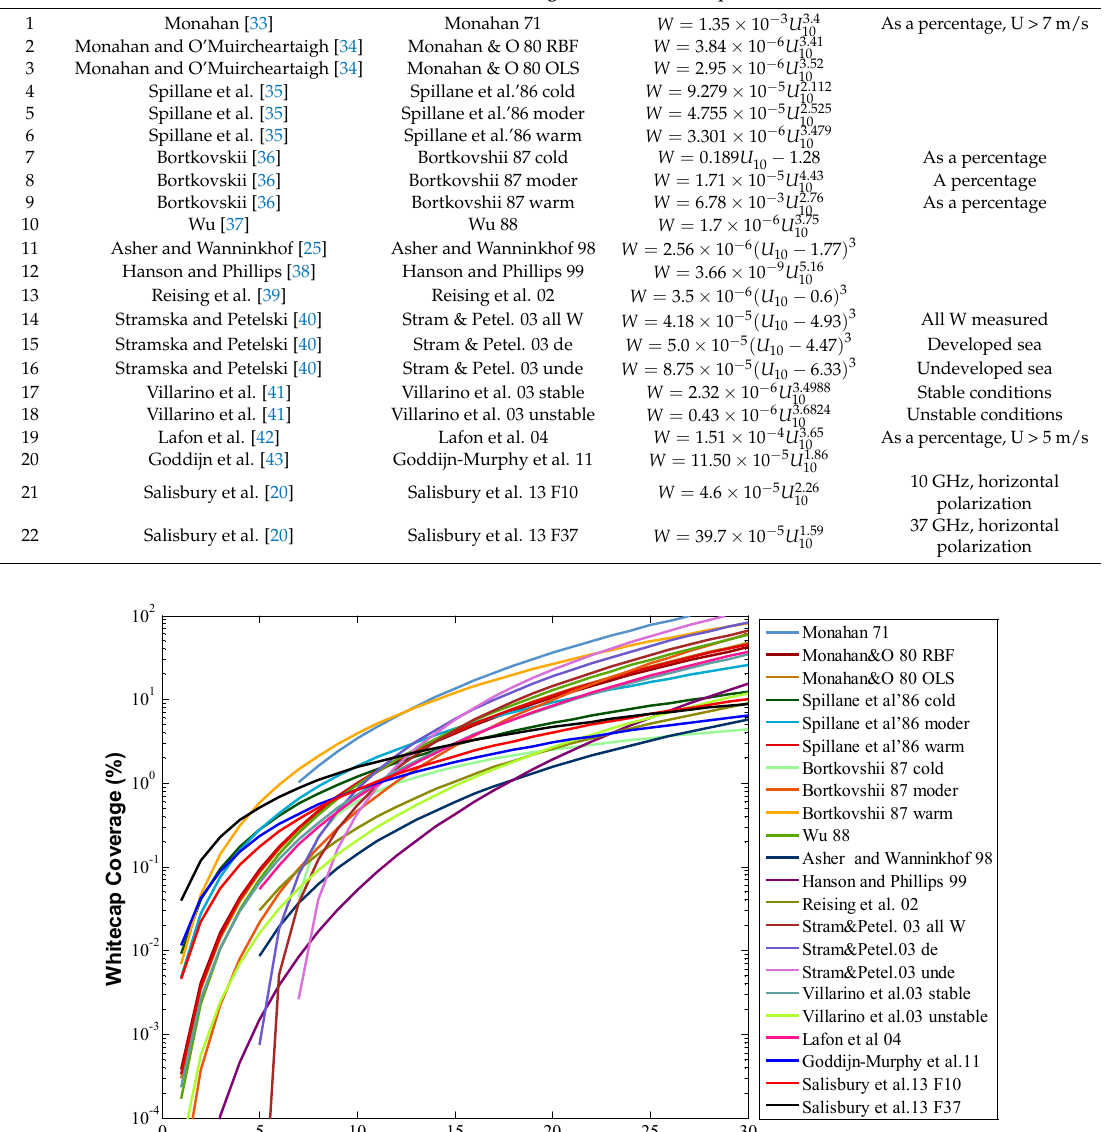
Table 1. Statistics on the relationship between whitecap coverage and wind speed, W is the whitecap coverage. U 10 is the wind speed at 10 m above the sea surface.